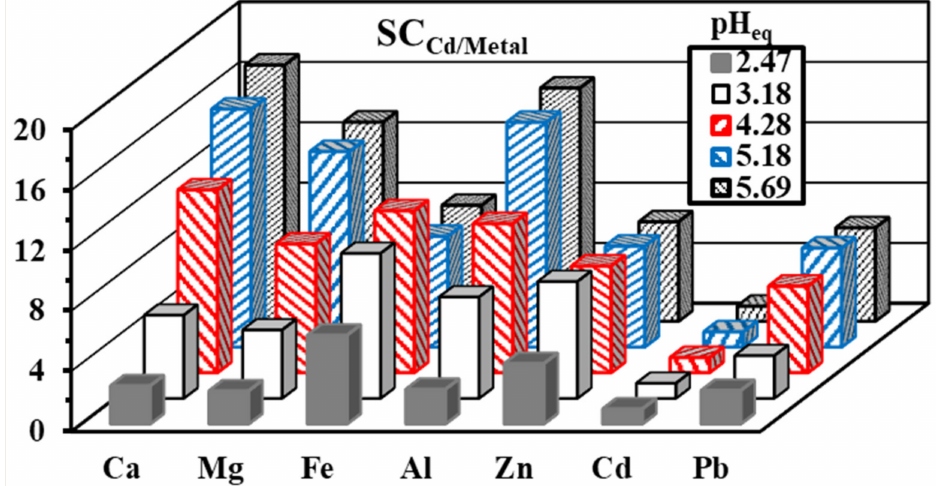
Figure 9. Selectivity coefficient of Cd metal against some heavy elements at different pH values.